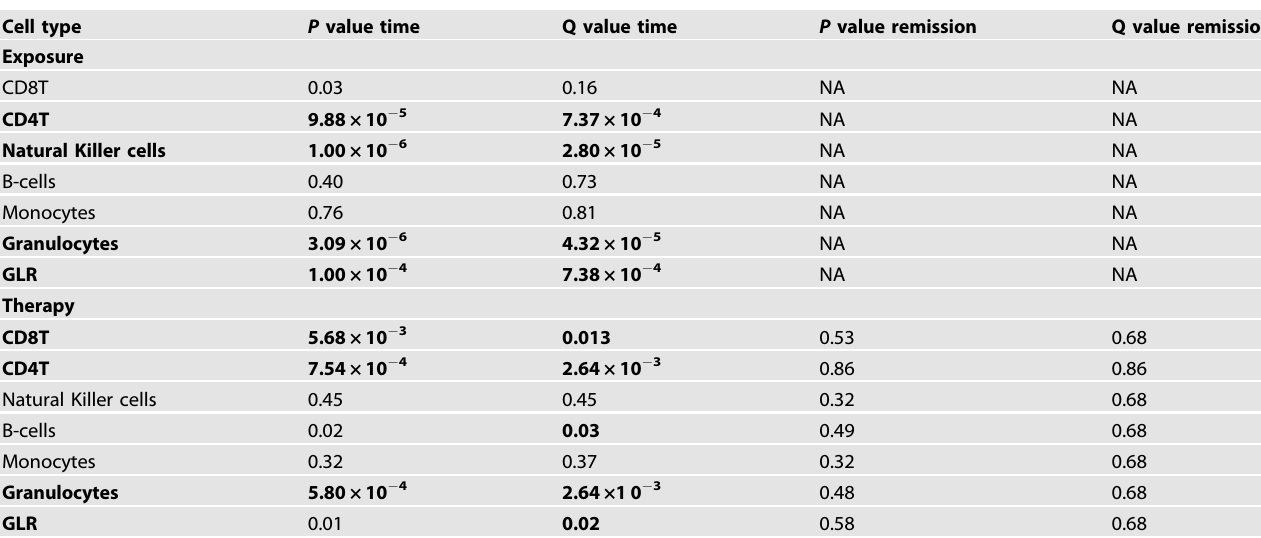
Table 1. Regulation of Immune Cell